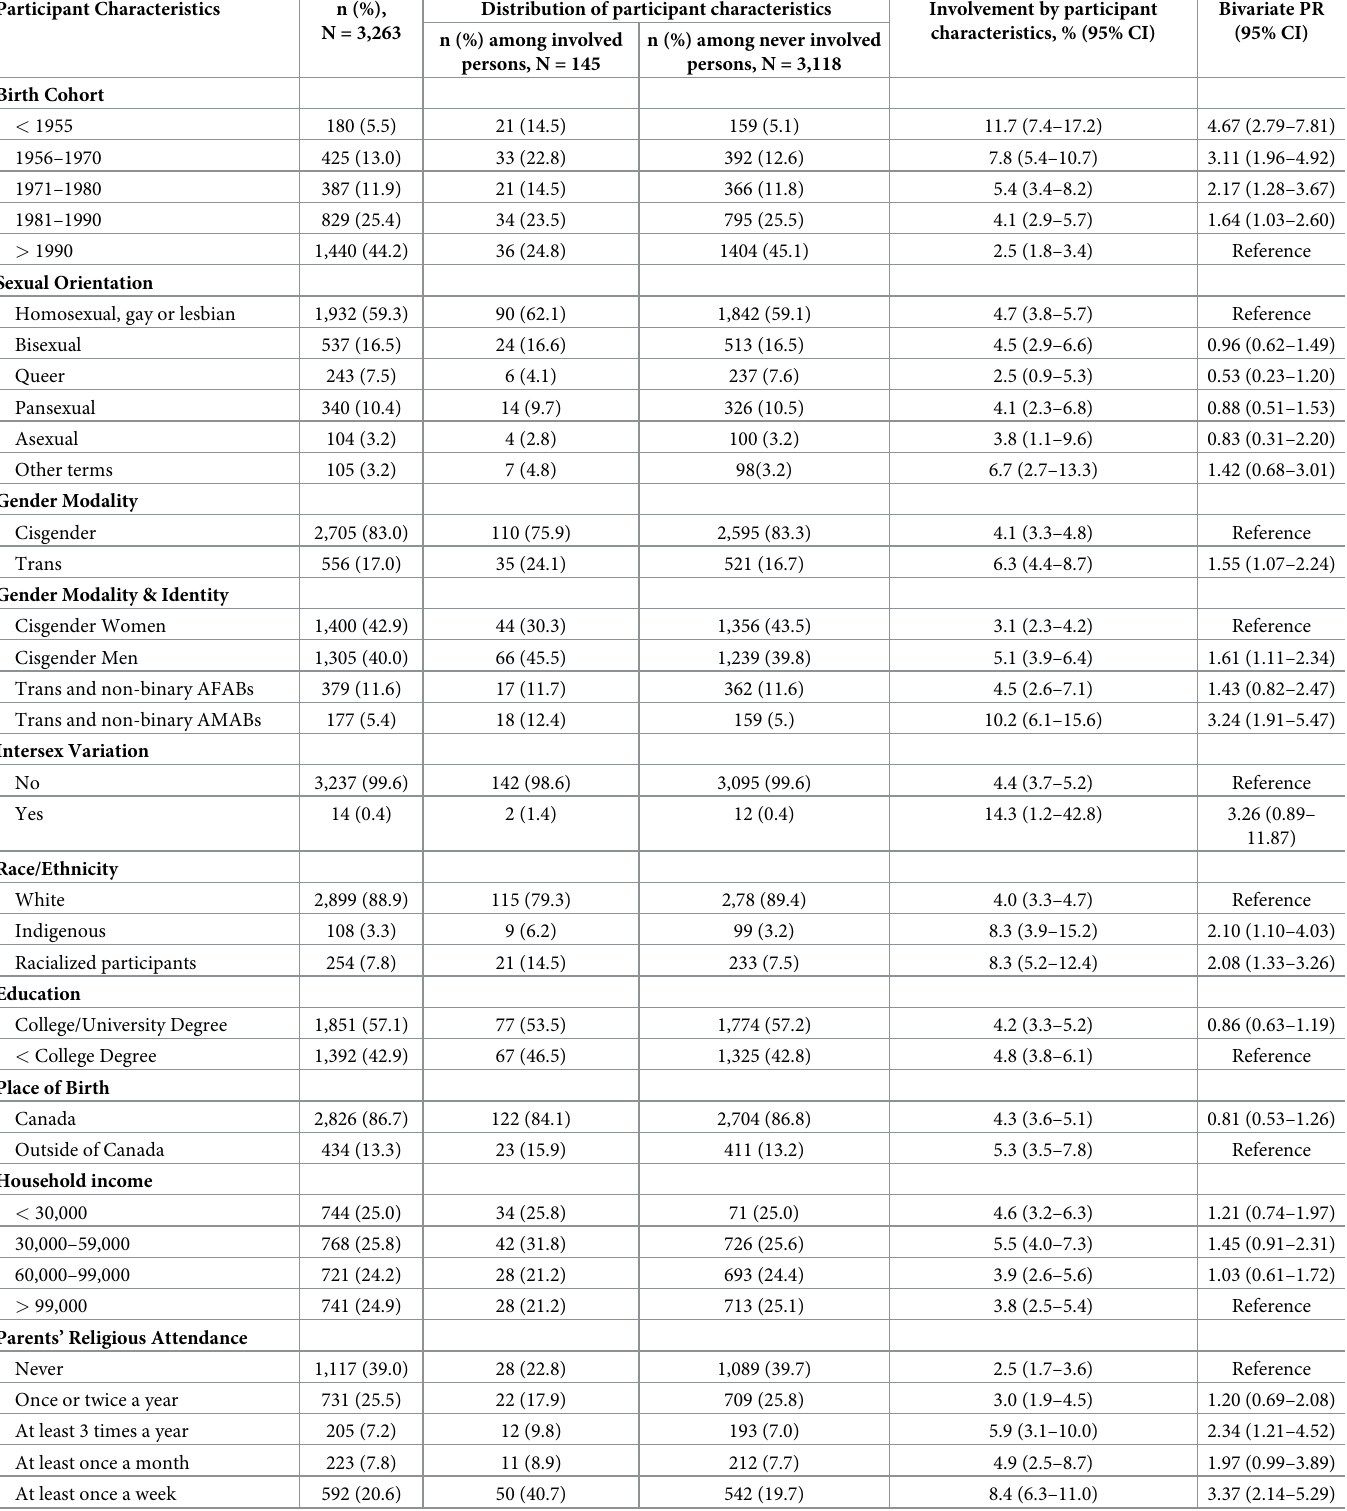
Table 6. Lifetime involvement in SOGIE conversion services among LGBTQI2+ persons in Quebec, Canada, by participant